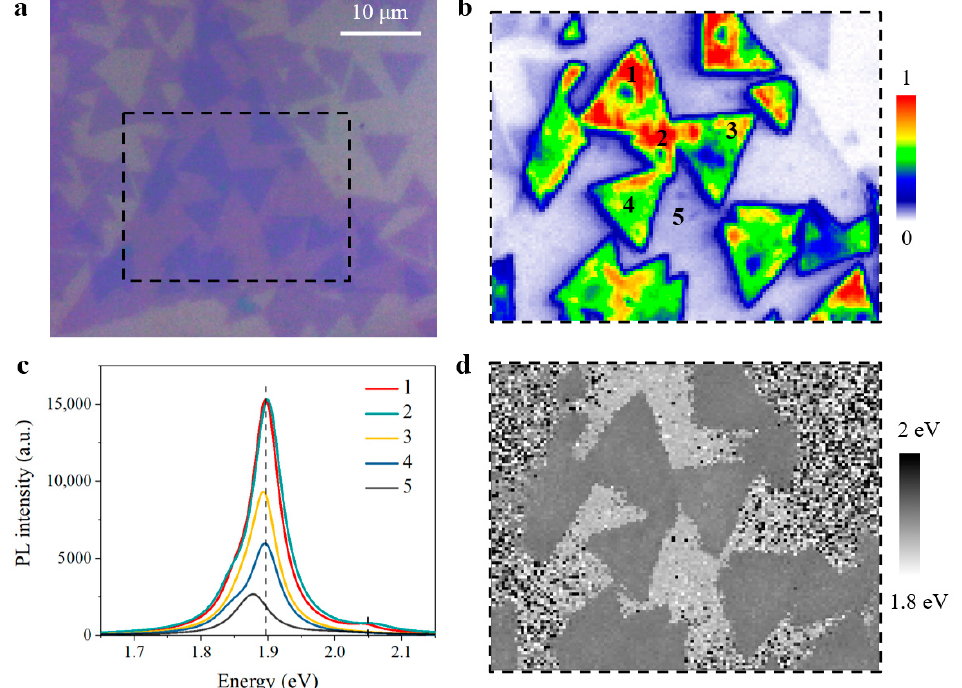
Figure 6. PL mapping of twisted MoS 2 bilayers with anomalous interlayer coupling from the second sample batch. ( a ) Optical image. ( b ) Normalized PL mapping result. ( c ) PL spectra of monolayer and anomalous bilayer regions marked in ( b ). ( d ) The emission peaks of PL intensity maximum in ( b ).